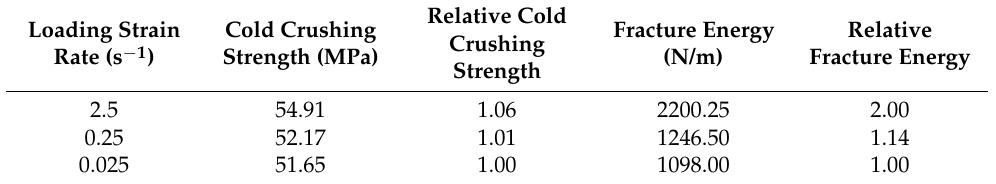
Table 3. Cold crushing strengths and fracture energies of the cases with varying loading strain rates. Loading Strain